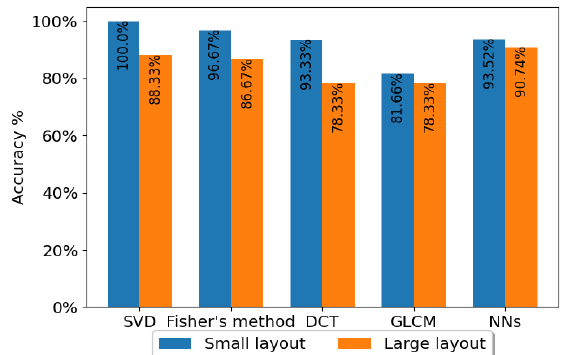
Figure 13. Comparison of the effect of small-layout and large-layout data in classification performance. The LR classifier with the four feature extraction methods are applied on the single-subject activities for small-layout and the single-subject activities for large-layout, as well as the CNN-LSTM using Coventry-2018 Sensor-1 large- and small-layout